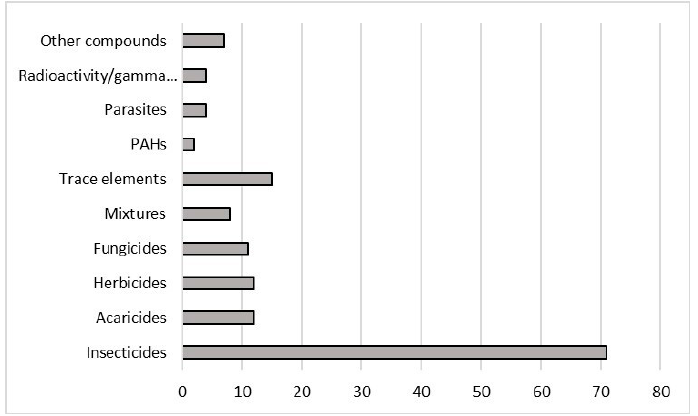
Figure 4. Number of studies, divided by kind of compounds, on Apis mellifera , that met the criteria for inclusion in this